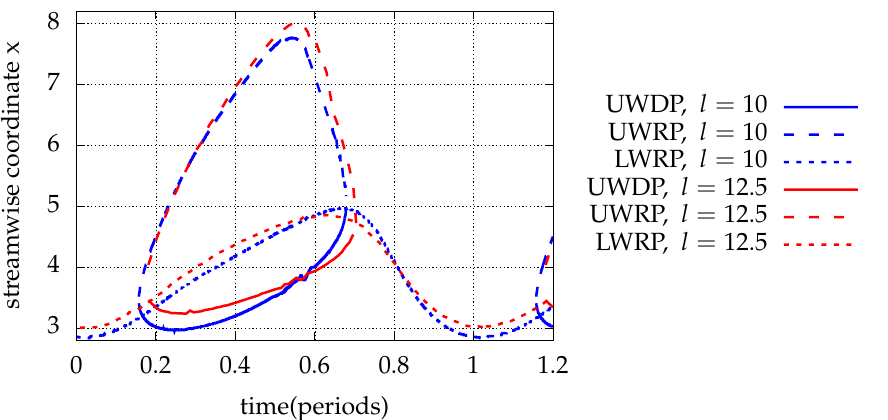
Figure 16. Upper wall detachment position (UWDP) and upper and lower wall reattachment positions (UWRP, LWRP) for unsteady periodic inflow with α = 0.05 and Re = 400 and oscillating part of the bottom wall with ω = 0.05, A = 0.2, l = 12.5. Comparison with results for l = 10.